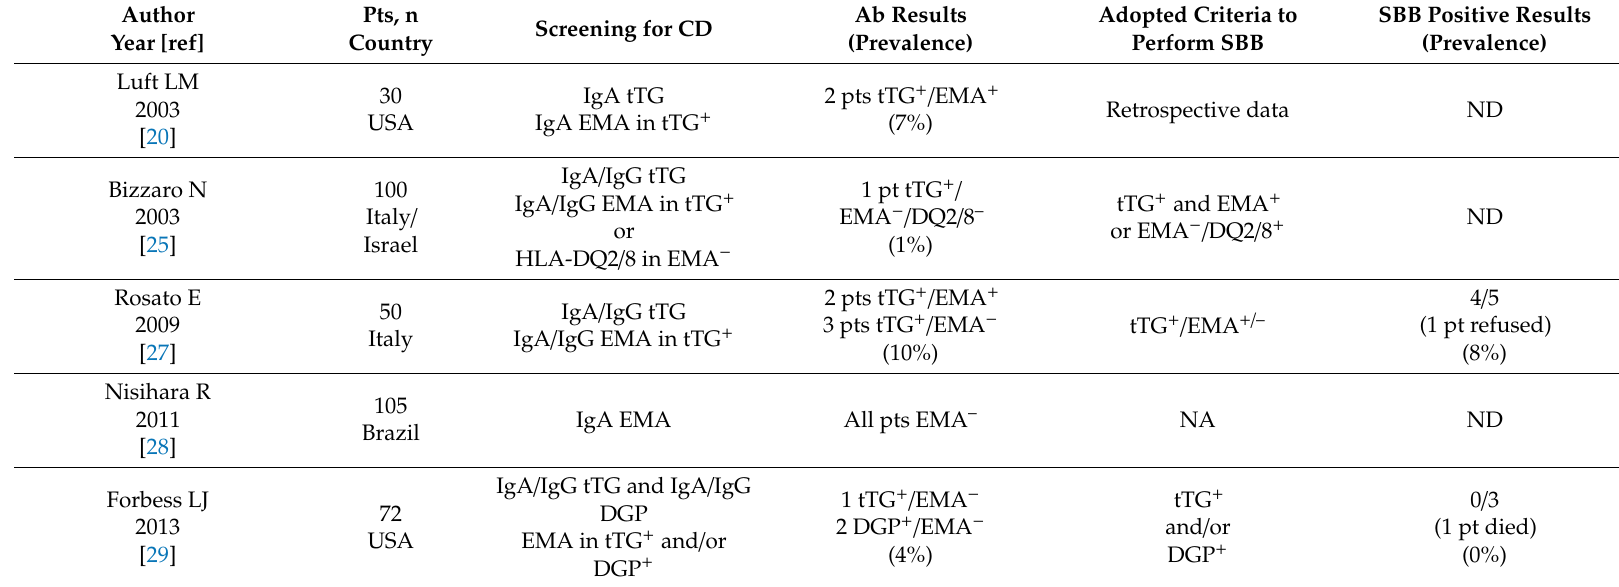
Table 3. Celiac disease prevalence in systemic